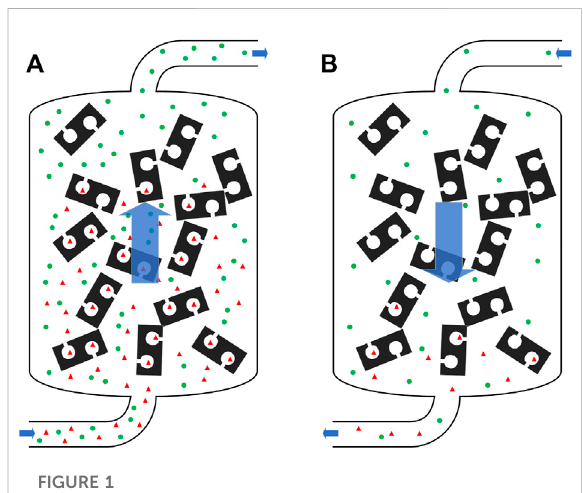
FIGURE 1 Schematic illustration of the major steps involved in a PSA process (A) Adsorption (B)